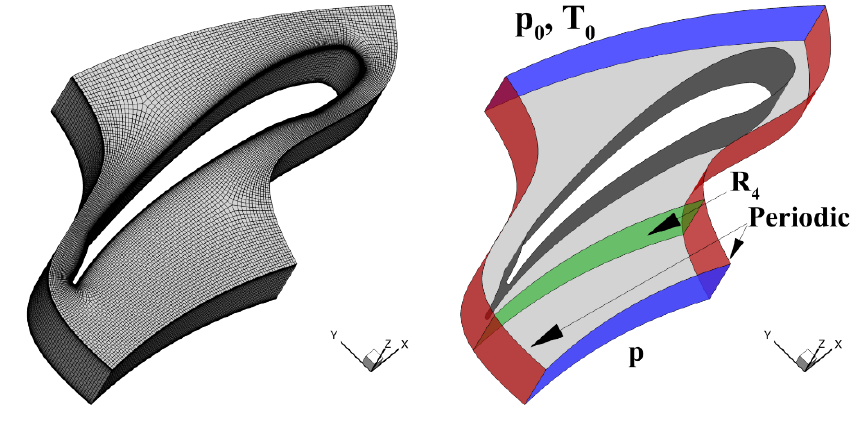
Figure 4. Mesh and computational domain for 15 vane–75° outlet metal angle case.